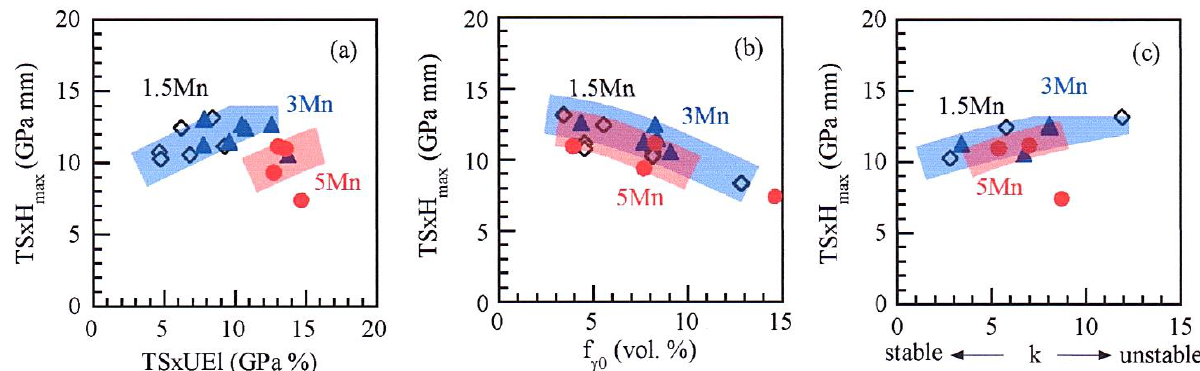
Figure 14. Relationships between TS × H max and ( a ) TS × UEl, ( b ) initial retained austenite fraction ( f γ 0 ), and ( c ) strain- induced transformation factor ( k ) in the 1.5Mn ( ◇ ), 3Mn ( ▲ ), and 5Mn ( ● ) steels. IT temperatures are between M s and M f − 100 C.